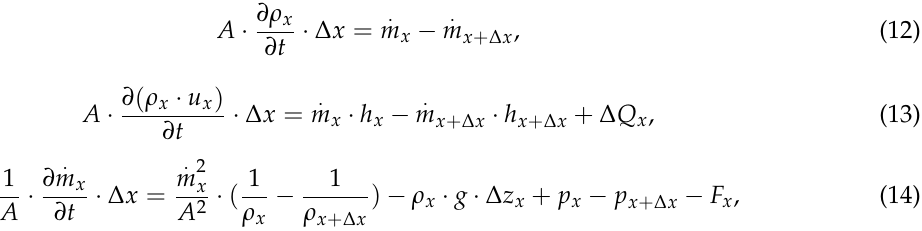
Figure 5. Schematic of the two ‐ tank storage module.